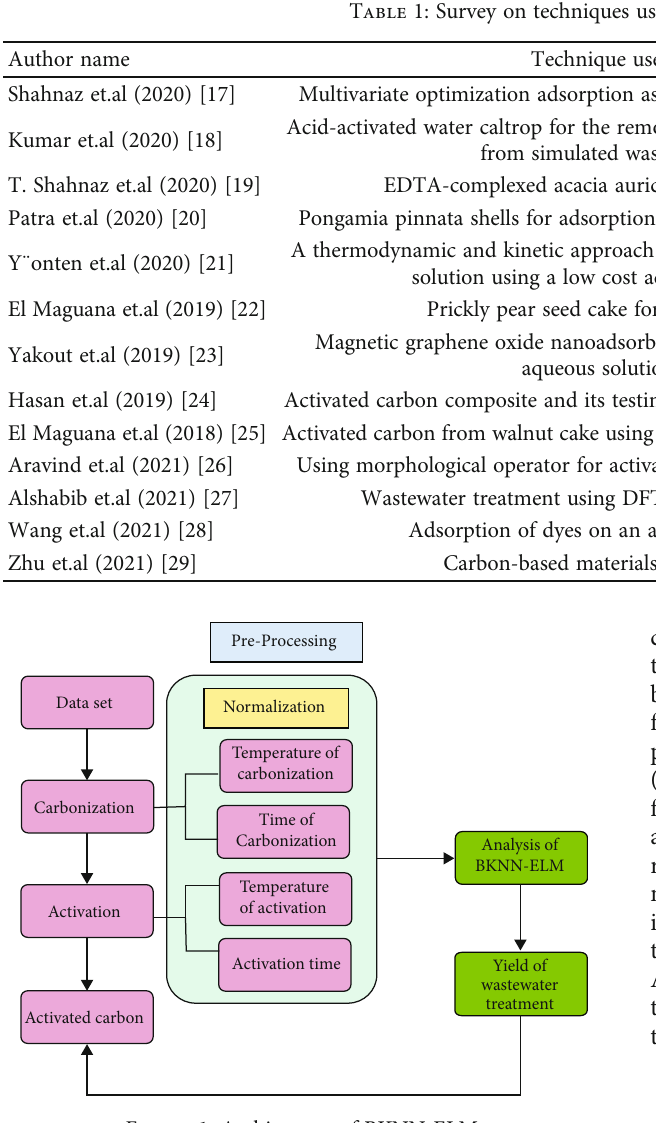
Figure 1: Architecture of